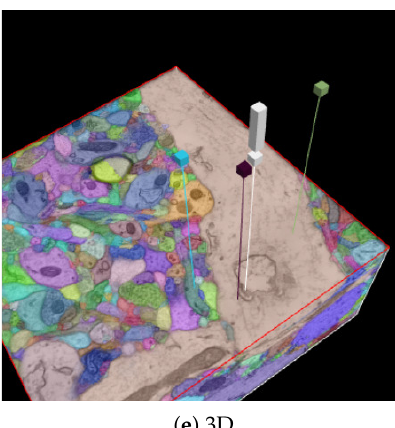
Figure 6. The output of our automatic segmentation pipeline requires proofreading to correct split and merge errors. These errors can be fixed with simple user interaction: ( a ) Split errors can be corrected by joining segments; and ( b ) merge errors can be corrected by drawing the missing boundary. Including these interactions; ( c ) we build the interactive proofreading tool Dojo with a minimalistic user interface, display-aware and demand-driven visualization, and integrated 3D volume rendering. Proofreaders can collaborate, each with cursors in ( d ) 2D and ( e ) 3D. The exclamation mark in ( e ) is used to request help at a specific region within the